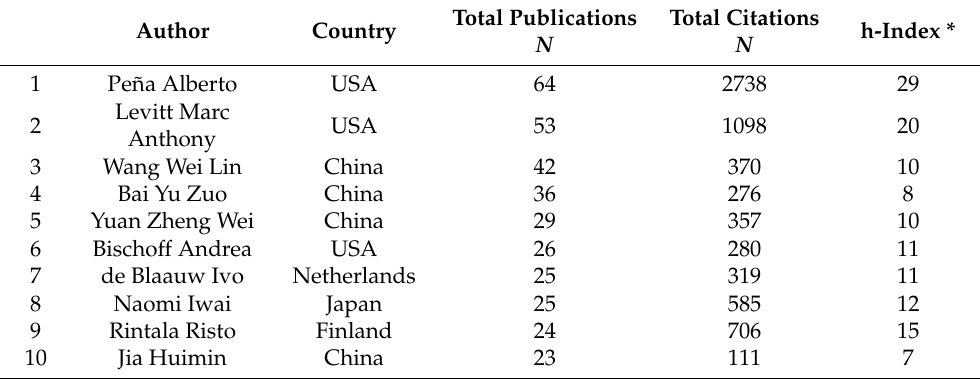
Table 2. Most productive authors publishing on ARM between 1970 and